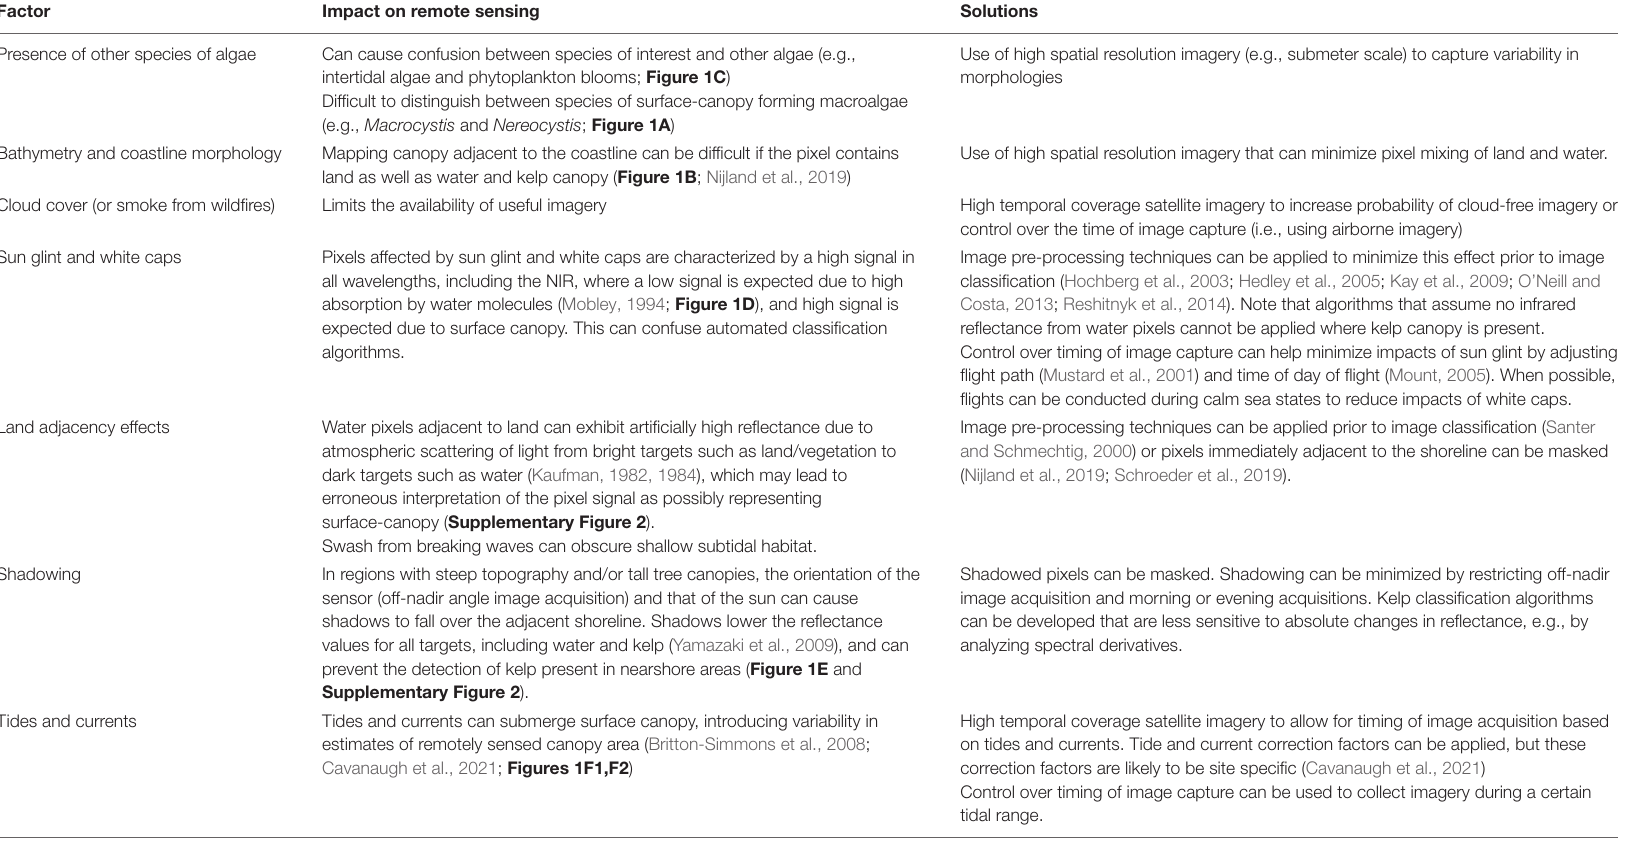
TABLE 1 | Physical and biological factors that influence the ability to detect surface-canopy forming kelps using airborne and spaceborne imagery. Factor Impact on remote sensing Solutions Presence of other species of algae